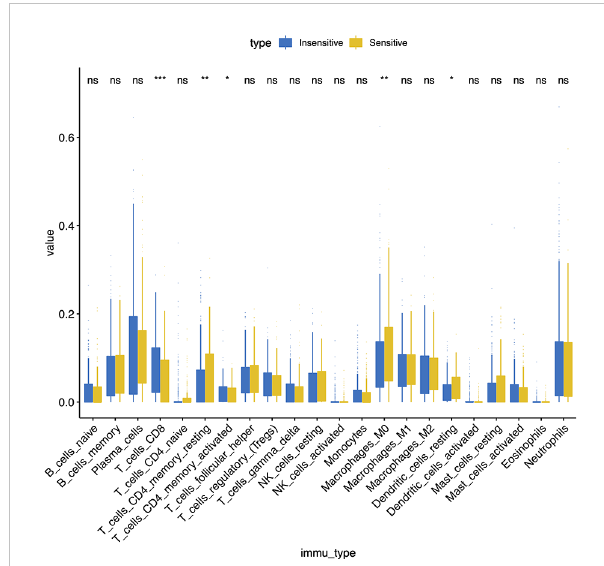
FIGURE 2 Immune in fi ltration ratio analysis of taxane anthracycline resistance susceptibility samples in GSE25066.